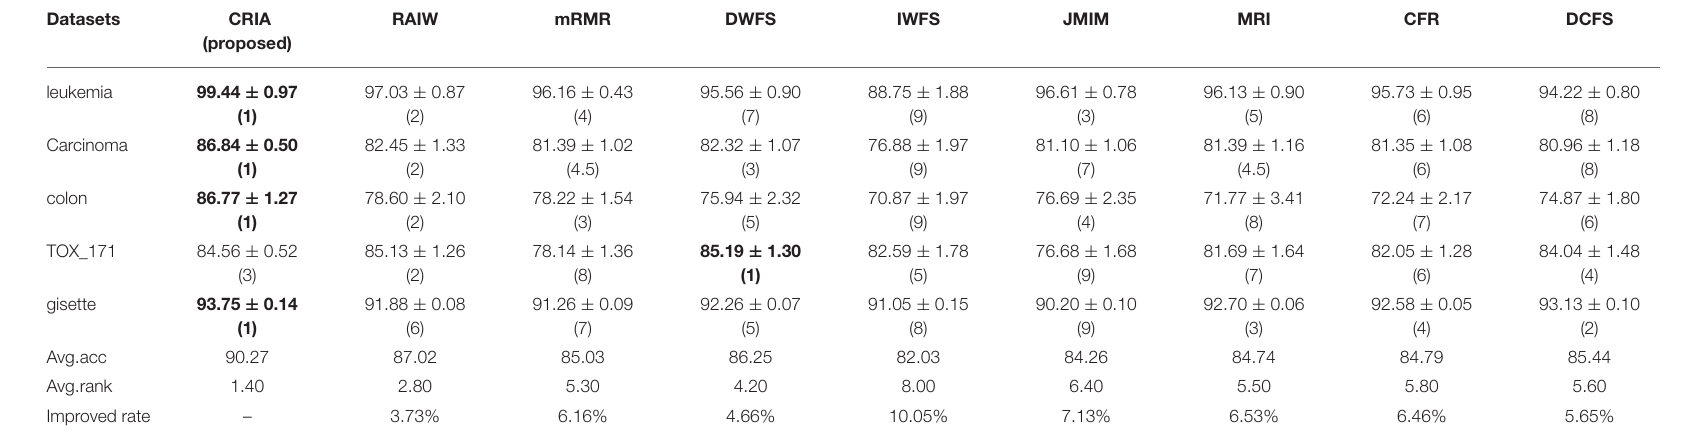
TABLE 4 | Comparision (mean ± std.dev.) of performance between CRIA and other 8 algorithms with IB1 classifier. Datasets